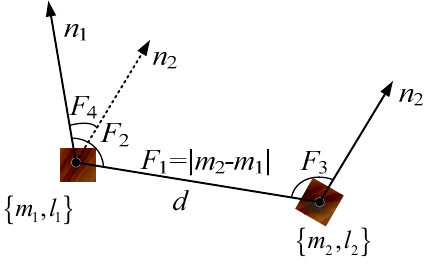
Figure 6. Local patch point pair feature (LPPPF).